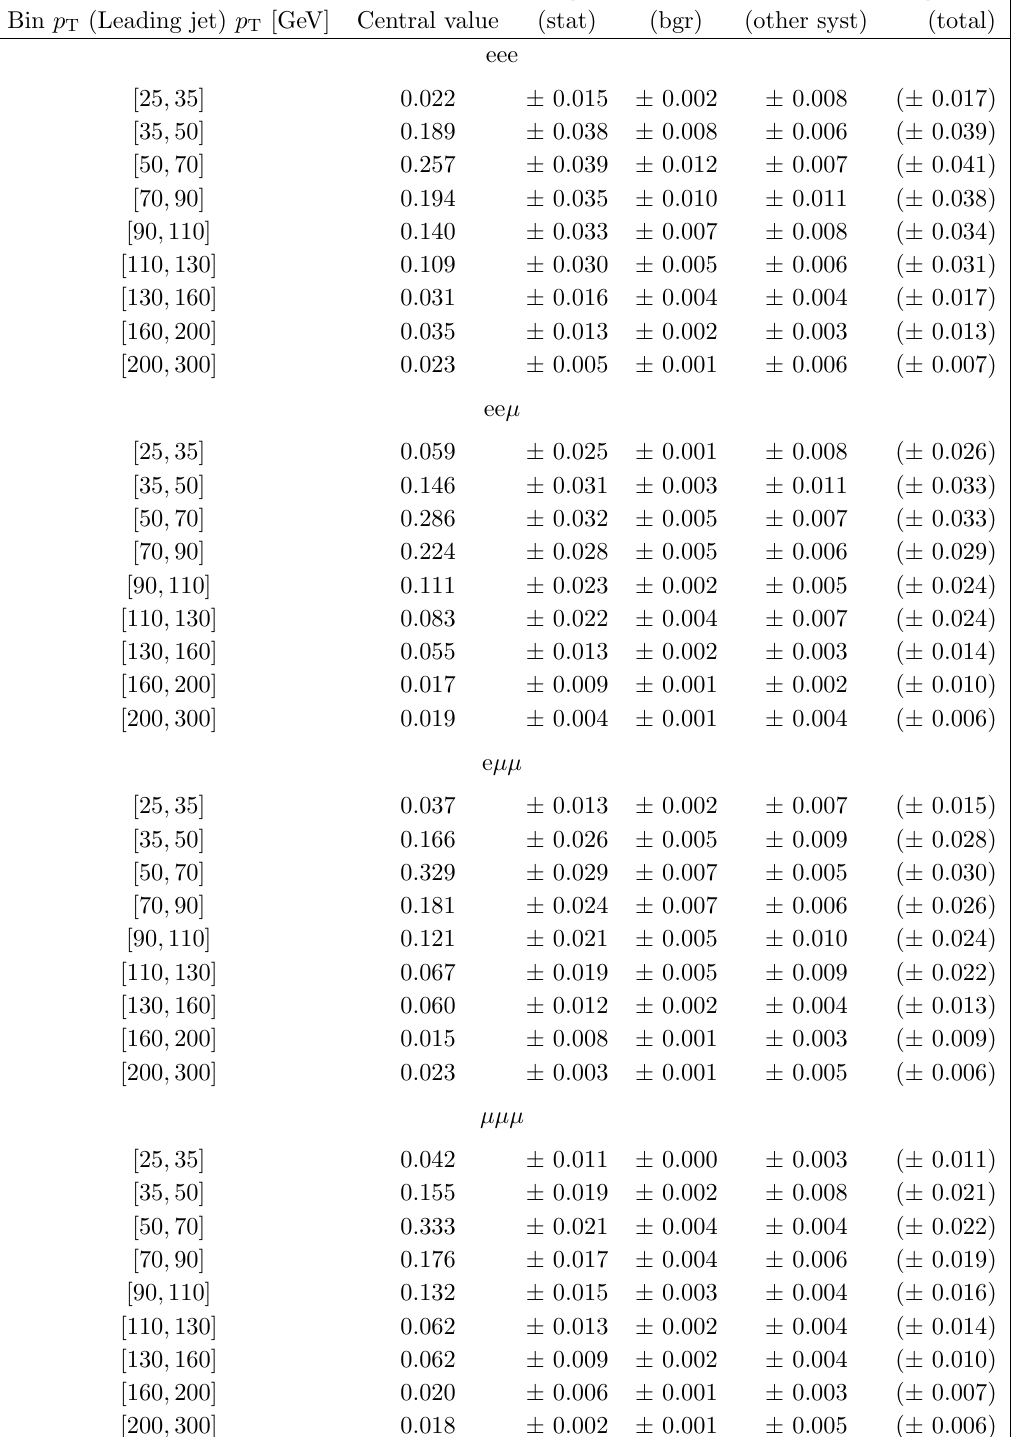
Table 10 . Di(cid:11)erential cross section in bins of p T (Leading jet). Values are expressed as a fraction of the total cross section. The eee, ee (cid:22) , e (cid:22)(cid:22) , and (cid:22)(cid:22)(cid:22) (cid:12)nal states are